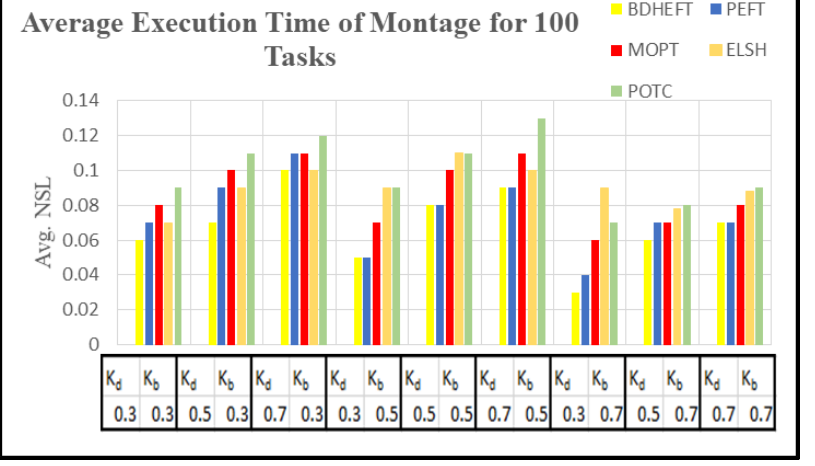
Figure 10. Average execution time of the montage workflow for different deadline factors.